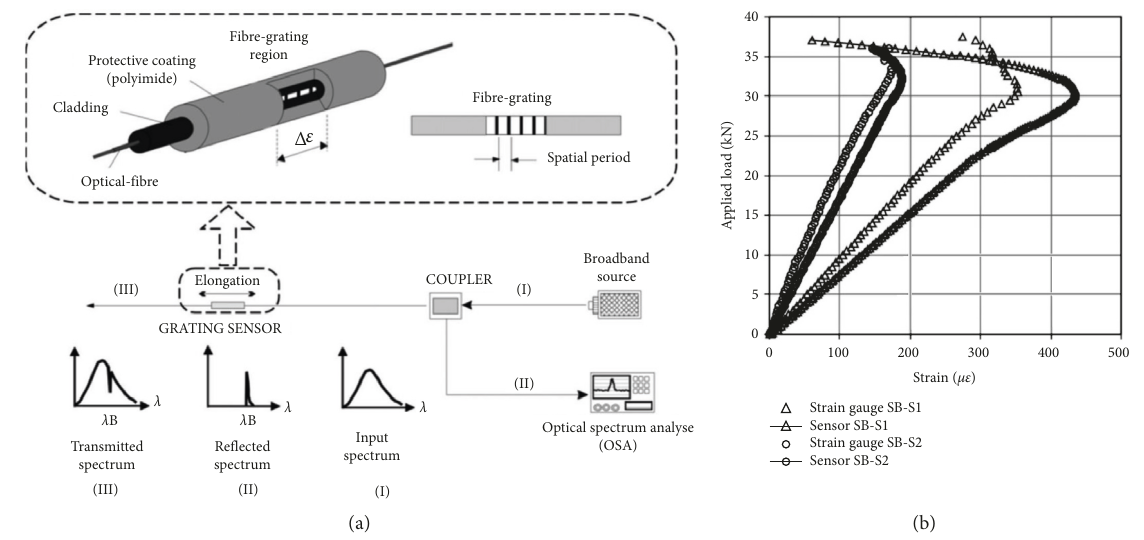
Figure 12: (a) Schematic diagram of the OFRC system for strain measurement [75]. (b) Comparison of strain measured by OFRC concrete sensor and strain gauge. [75].